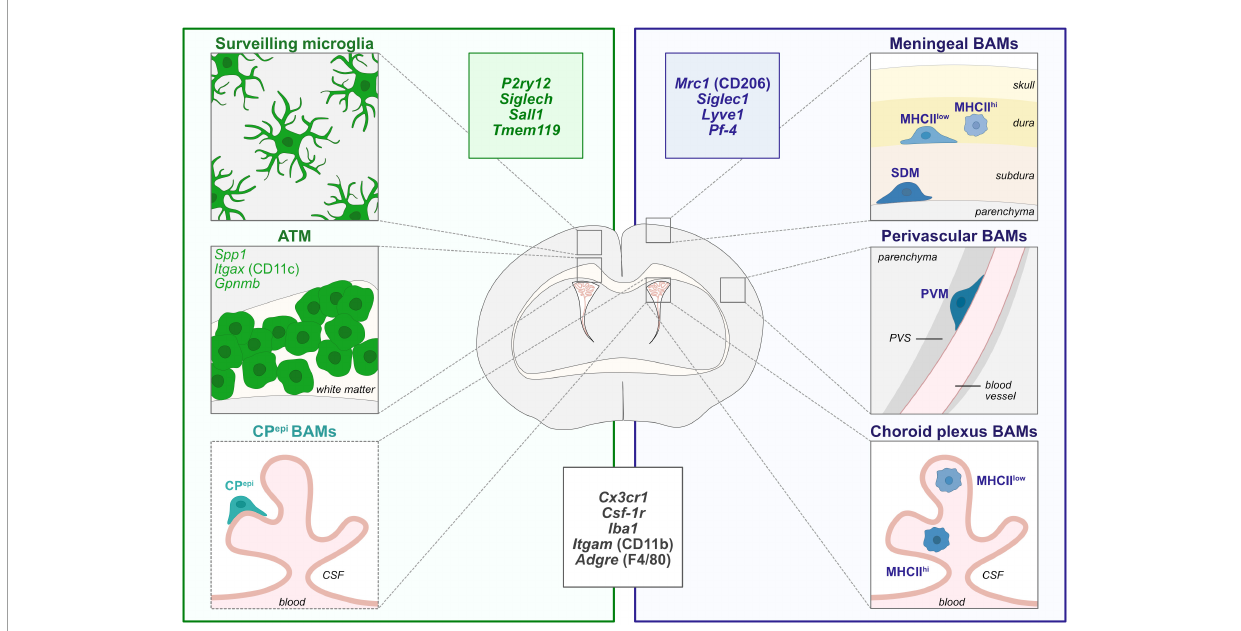
FIGURE1 Diversity of CNS macrophages in steady-state conditions. During steady-state, microglia are localized within the brain parenchyma and are highly heterogeneous in morphologies, localization and molecular signatures throughout brain development. In particular, axon tract-associated microglia (ATM)/proliferative-region-associated microglia (PAM)/Cd11c-positive microglia have been described during early postnatal development in the corpus callosum and other white matter regions. Border-associated macrophages (BAMs) reside at distinct interfaces of the CNS such as the meninges, choroid plexus and perivascular space (Goldmann et al., 2016; Mrdjen et al., 2018; Van Hove et al., 2019; Utz et al., 2020; Masuda et al., 2022). Non-parenchymal microglia-like Kolmer’s epiplexus BAMs (CP epi ) reside in the apical surface of the choroid plexus facing the cerebrospinal fluid (CSF) and share some transcriptional features with microglia and ATM signature (Van Hove et al., 2019). In particular, meningeal MHCII low and MHCII high macrophages are localized in the dura matter while subdural macrophages (SDM) are restrained to the subdural area. Finally, while perivascular macrophages (PVM) are found in the perivascular space, between the vascular basement membrane and the glia limitans of the parenchyma, choroid plexus contains MHCII low and MHCII high BAMs. The insets depict the most commonly used markers for microglia (green), BAMs (blue), and common markers to both populations (black). ATM, axon tract-associated microglia; BAMs, border-associated macrophages; CP epi , Kolmer’s epiplexus; CSF, cerebrospinal fluid; MHCII, major histocompatibility complex class II; PVS, perivascular space; PVM, perivascular macrophage; SDM, subdural